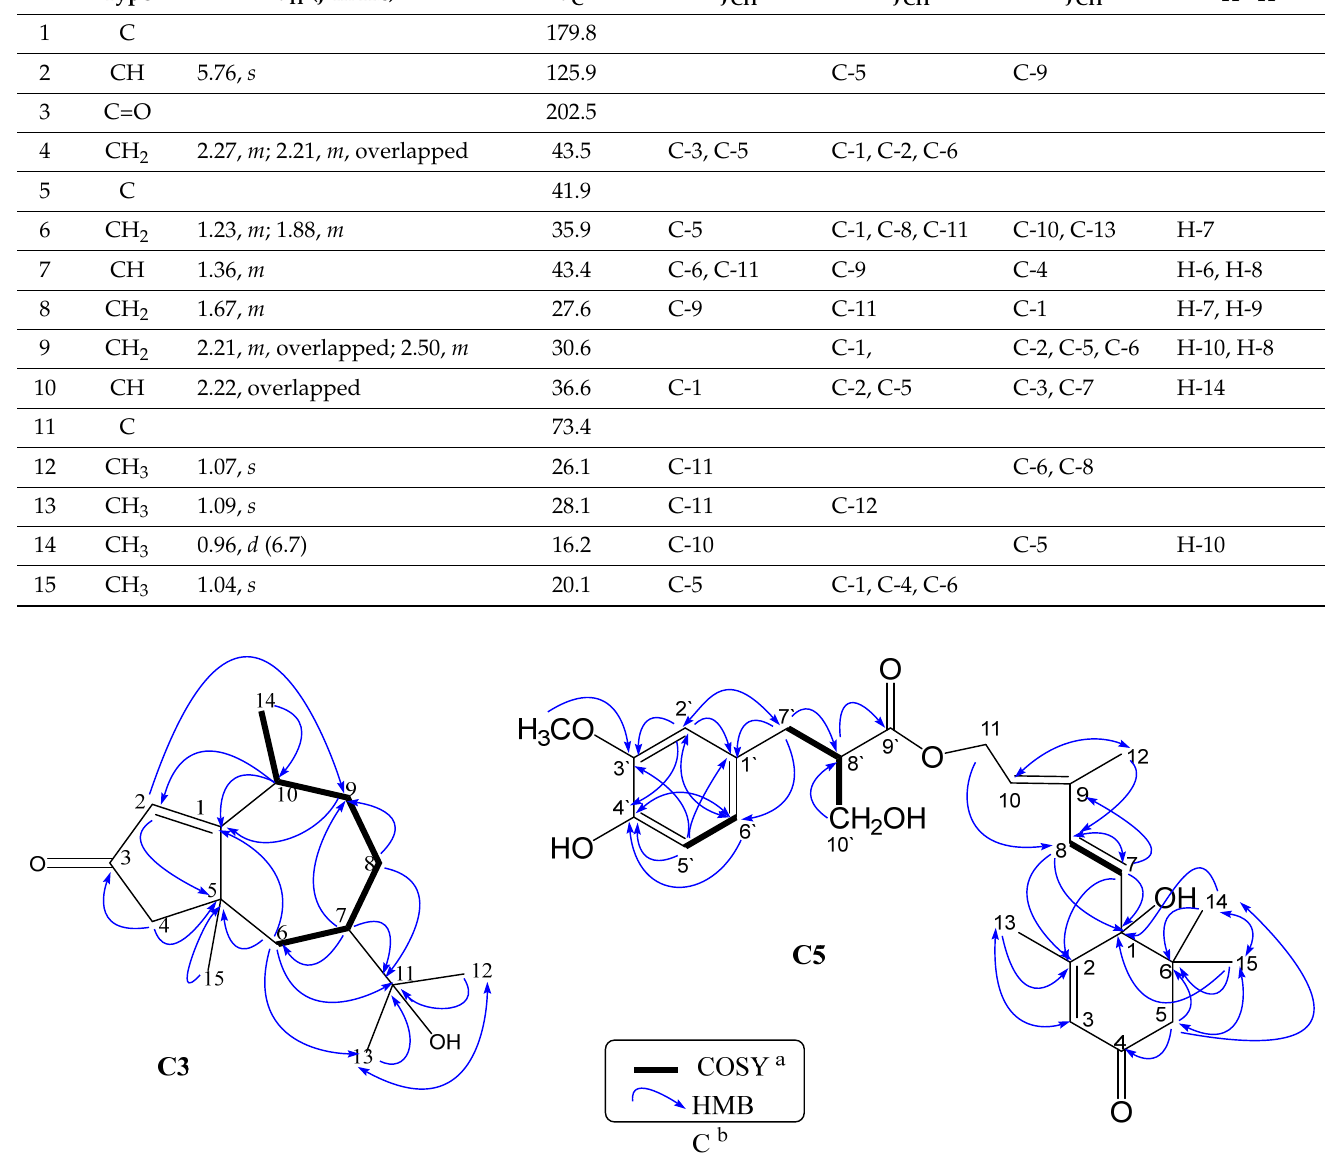
Table 1. NMR spectral data of compound C3 in CD 3 OD (500 MHz for 1 H- and 125 MHz for 13 C-NMR).